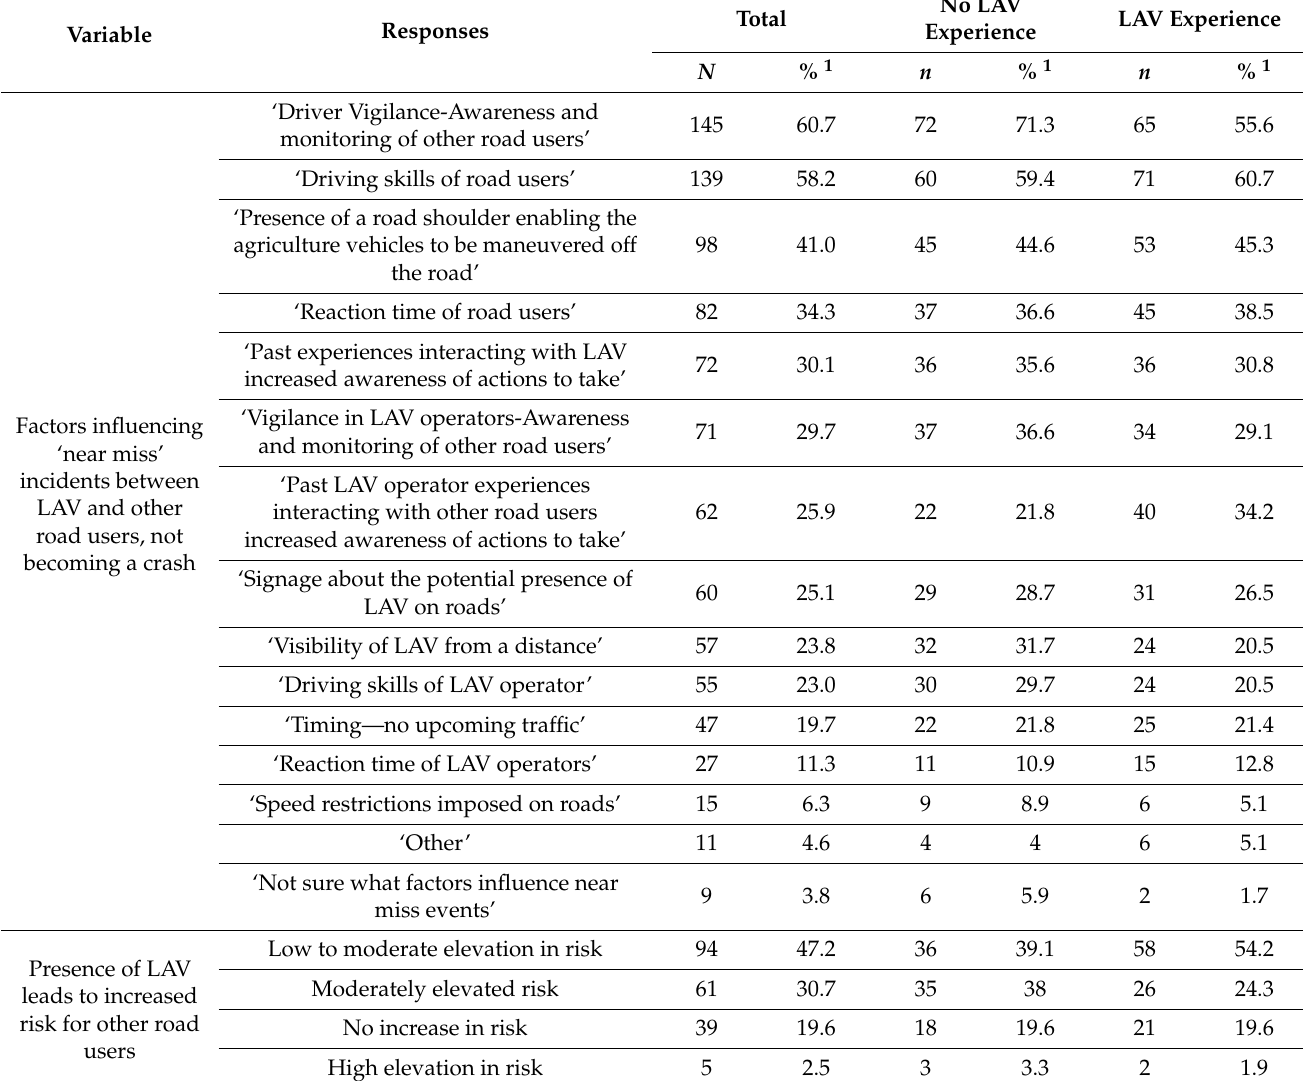
Table 4. Large agricultural vehicles’ presence on roads: Risk